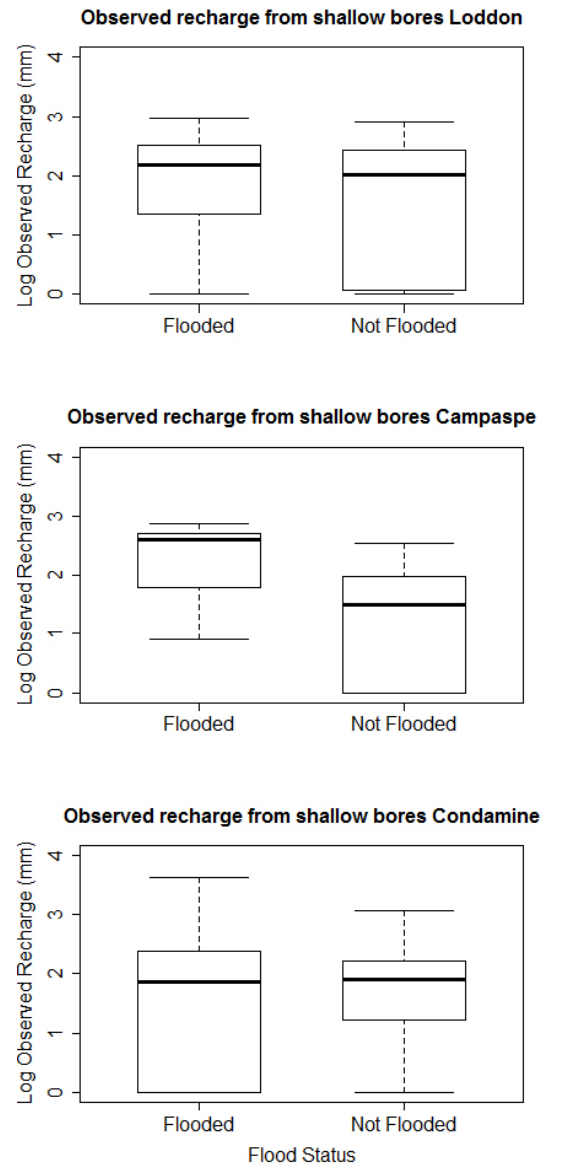
Fig. 6. Box plots of log recharge calculated from bore responses in flooded versus non-flooded areas (defined by modelled OFR greater than or less than 1 mm over the flood period) for the Loddon, Cam- paspe and Condamine catchments. A two tailed t test with unequal variance indicated no statistical significance between the means for the Loddon catchment ( p = 0 . 08), significant difference for the Campaspe catchment ( p = 2 × 10 − 5 ) , but no statistical significance for the Condamine catchment ( p = 0 . 77).